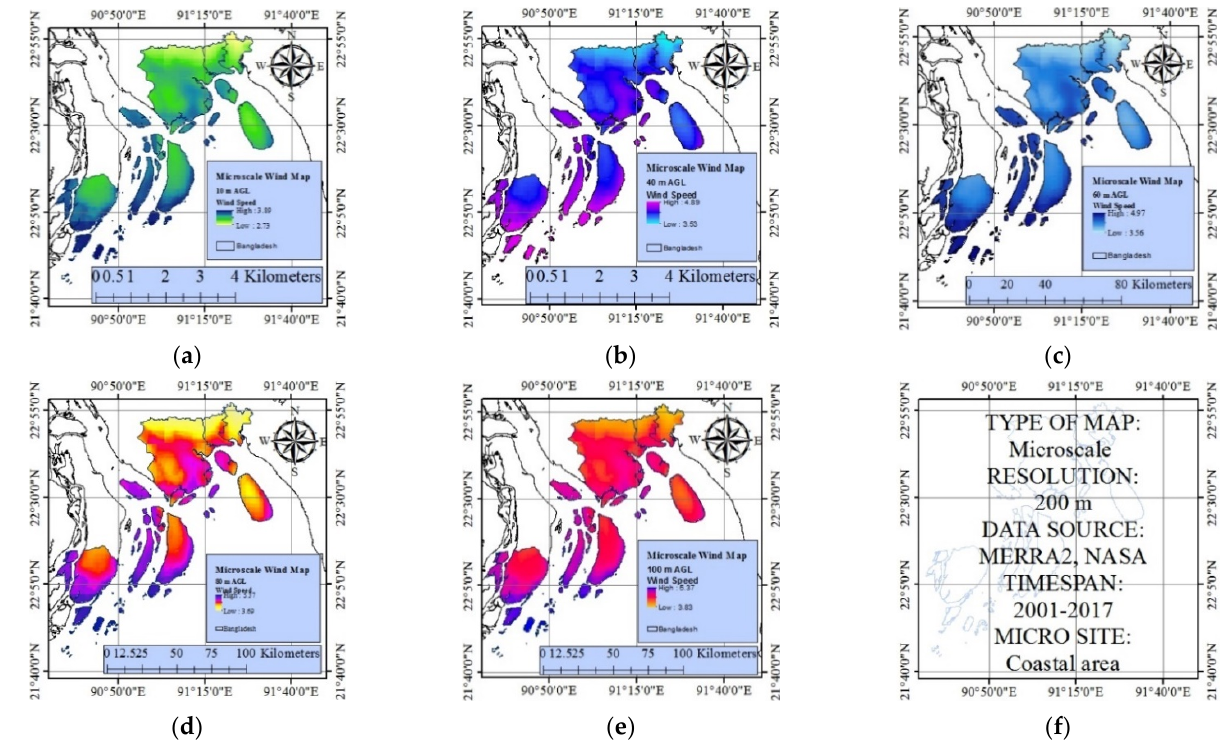
Figure 9. Microscale wind resource maps of the coastal area in Bangladesh at ( a ) 10 m AGL, ( b ) 40 m AGL, ( c ) 60 m AGL, ( d ) 80 m AGL, and ( e ) 100 m AGL and the ( f ) map specifications.